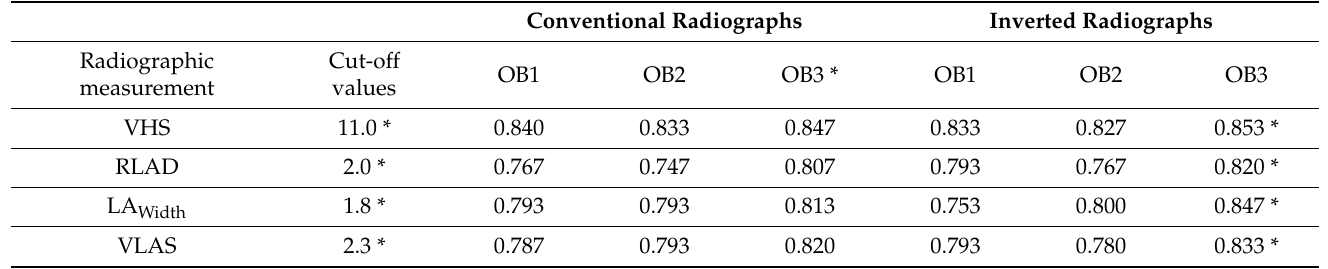
Table 3. Comparison of radiographic reassigning of the dogs with the echocardiographic assignment. Supplementary File